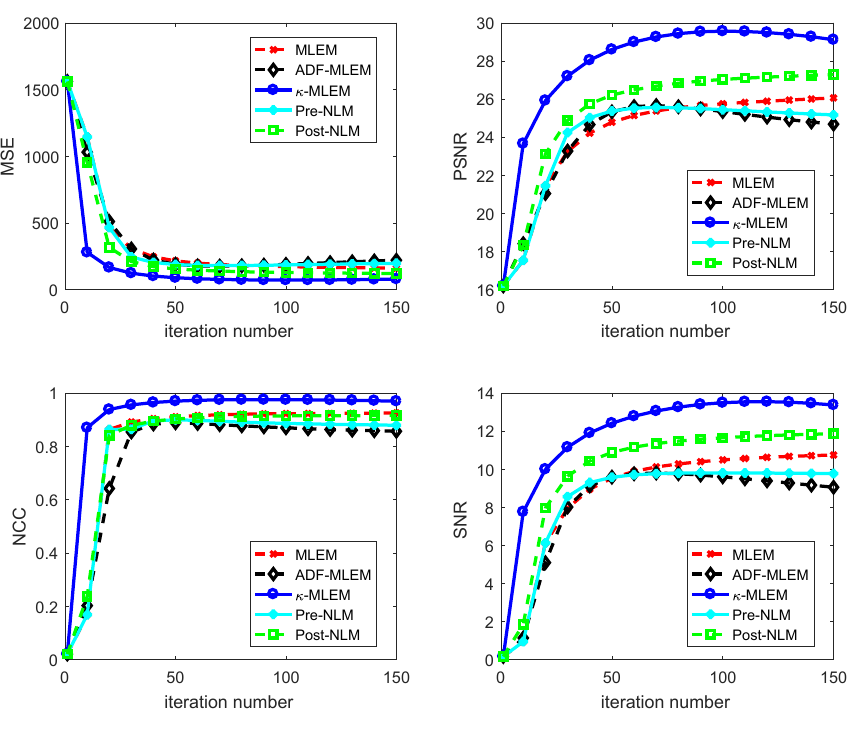
Figure 5. Comparative analysis of reconstructing a Hoffman phantom using various reconstruction methods by varying iteration number. MSE: mean square error; NCC: normalized cross-correlation; PSNR: peak signal-to-noise